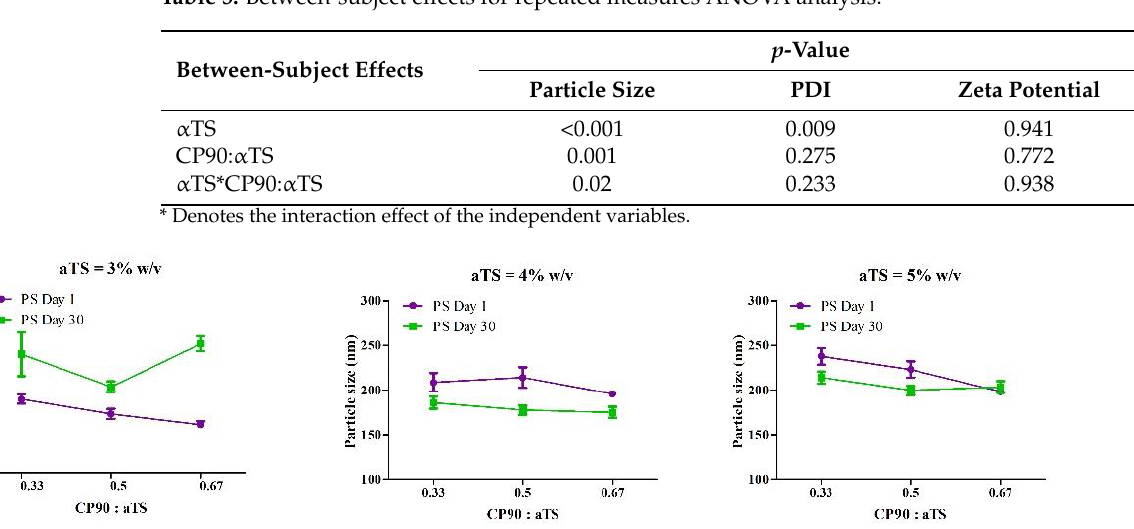
Table 5. Between-subject effects for repeated measures ANOVA analysis.